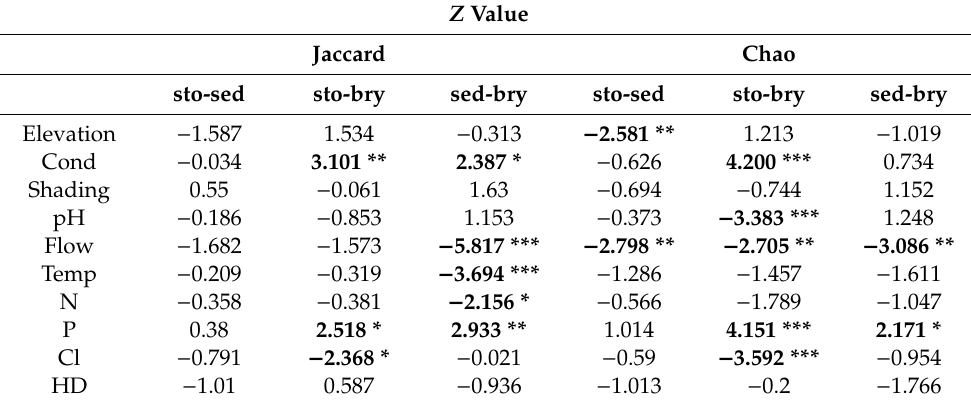
Table 3. Results of beta regression using as dependent variable Jaccard and Chao compositional turnover and environmental variables as predictors. Entry cells are z -values (the regression coe ffi cients divided by its standard error). Statistically significant values are in bold. Elevation [m], cond = conductivity [ µ S / cm], temp = temperature [ ◦ C], flow = flow velocity and shading in a five-point scale according to Cantonati et al. (2007), N = NO 3 -N [mg / L], P = Total Phosphorus (TP), Cl =